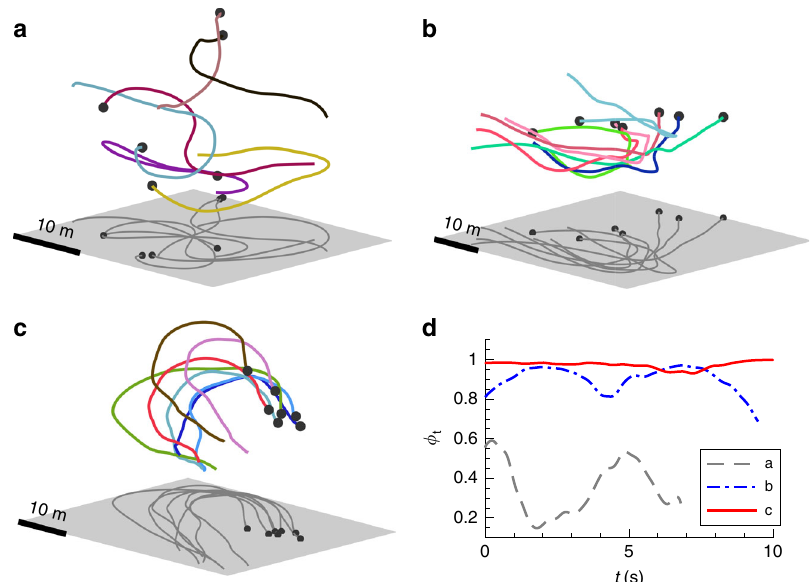
Fig. 2 Three representative mobbing fl ocks showing increasing group order with group density. a Flock at low density ( ρ = 0.002 m − 3 ). b Flock at moderate density ( ρ = 0.008m − 3 ). c Flock at high density ( ρ = 0.014 m − 3 ). d Instantaneous group order ϕ t for the fl ocks shown in ( a – c ). For a , c the meanings of the coloured lines, black dots, and grey planes are same as those shown Fig. 1